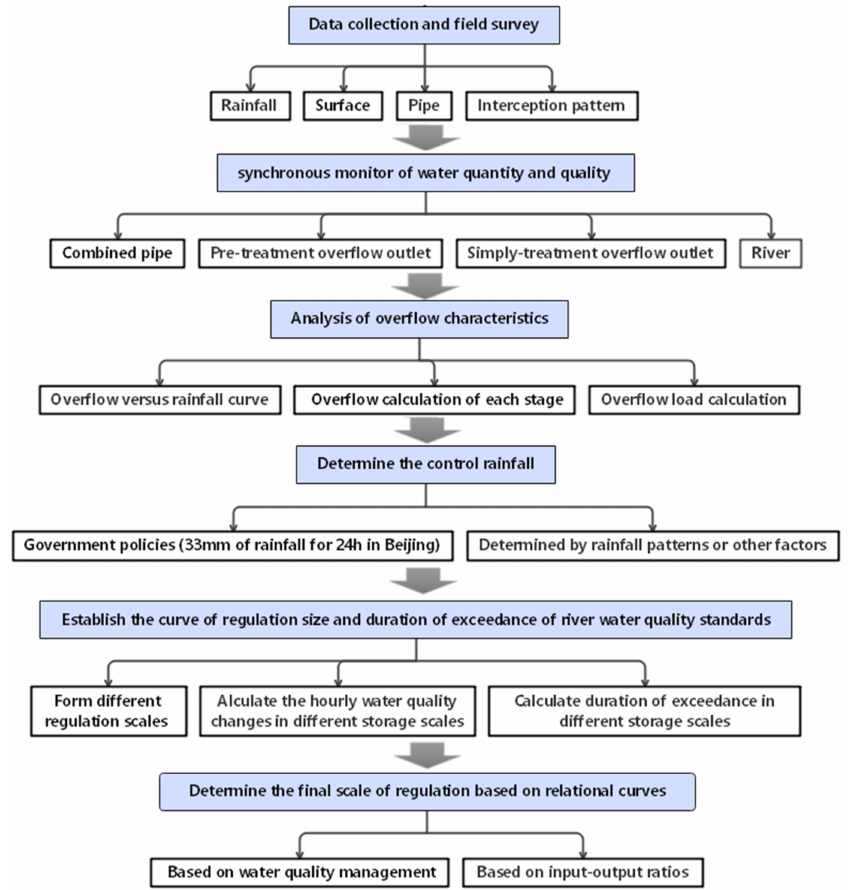
Figure 3. Technical process of the CSO comprehensive regulation method based on the synchronous monitoring of